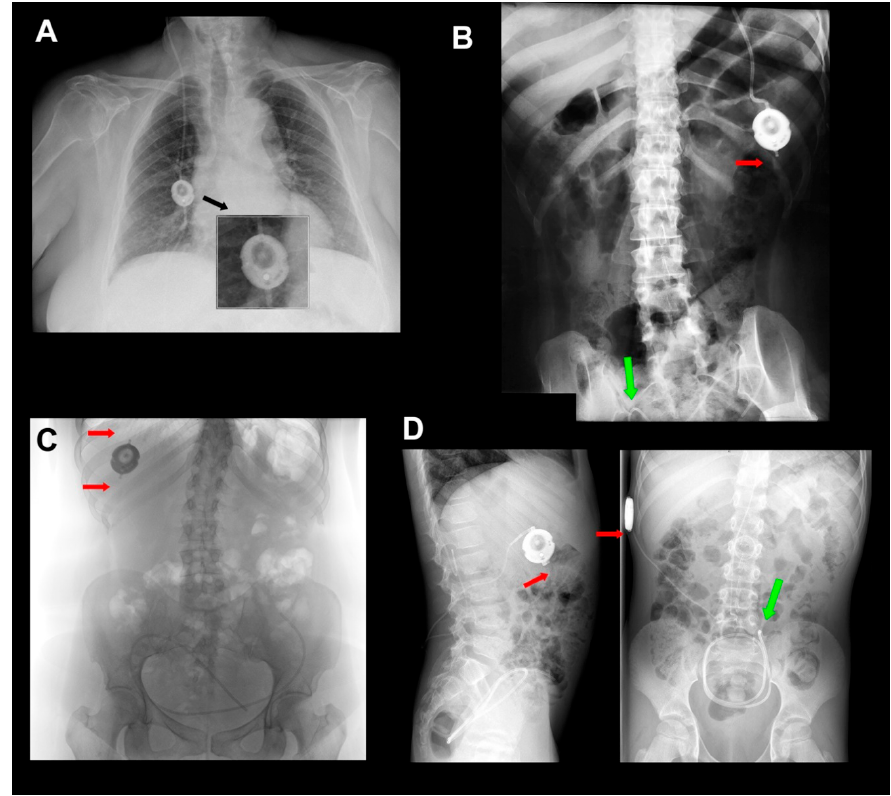
Figure 4. ( A ) A 10/50-cm H2O Miethke ® Dual-Switch valve (M-DSV) implanted in a 75-year-old woman affected by normal pressure hydrocephalus (NPH). Note how the vertical axis of the valve is perfectly aligned with the vertical axis of the patient’s spine. This is the recommended position when this type of valve is inserted. The device is anchored to the muscular plane by a 0-silk suture. ( B , C ) Chest X-ray of the thoracic implantation site of the M-DSV in several patients showing fractures of the catheters (red arrows). ( B ) Fracture of the distal catheter of the valve in a patient aged 23 years with hydrocephalus associated with spina bifida with abdominal migration of the catheter (green arrow). A fracture of the distal catheter was diagnosed six years after implantation of the valve. ( C ) Fracture of the proximal and distal catheters of the valve in a patient with hydrocephalus associated with a Chiari type 1 malformation (red arrows). ( D ) Early distal catheter fracture (red arrow) when using a lumbo-peritoneal M-DSV. Although it would be expected that this problem would happen a few years after the implantation of the valve, in our center, we observed this problem only ten months after valve implantation in a 12-year-old child. The valve was replaced, and the child presented this problem for the second time one year after this second implantation. Greater mobility in children, when compared to adults, reinforces the fact that this type of valve has been designed for adults and should not be implanted in